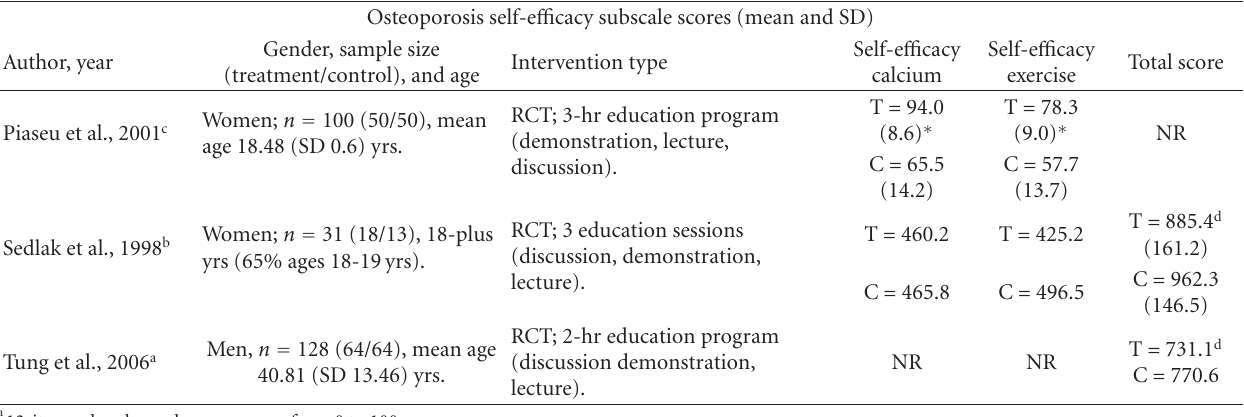
Table 4: Mean scores for osteoporosis self-e ffi cacy subscales of intervention studies. Osteoporosis self-e ffi cacy subscale scores (mean and